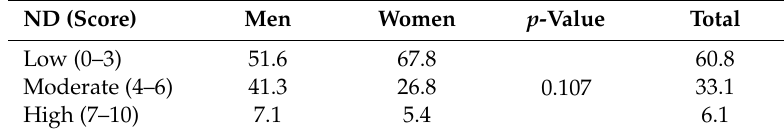
Table 3. Distribution (%) of nicotine dependence (ND) among daily smoking physicians in Estonia, 2014.